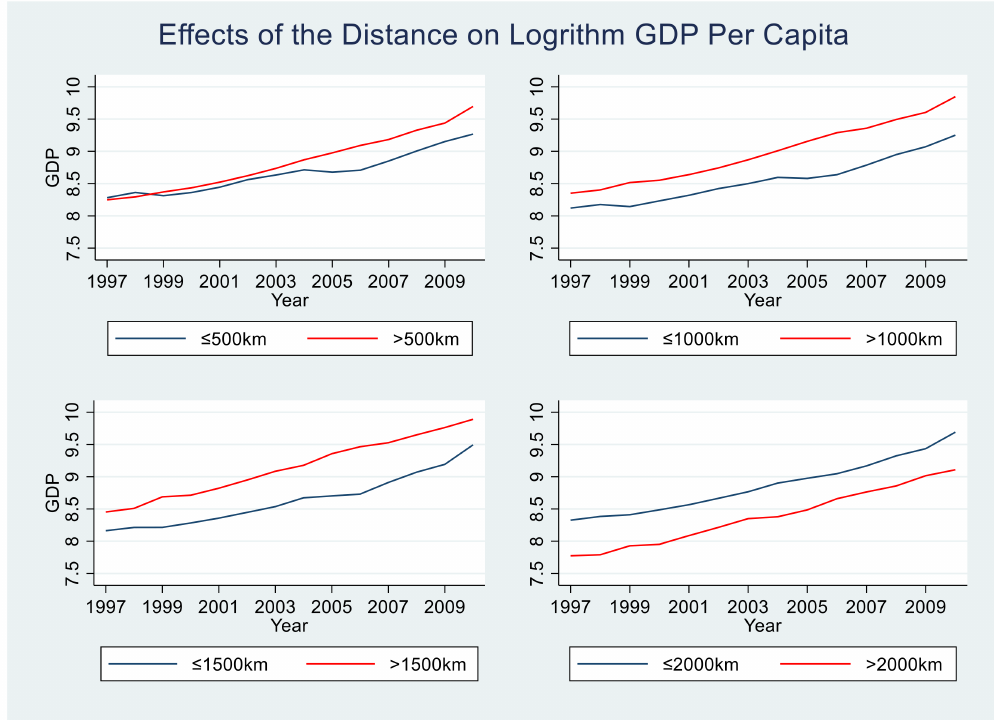
Figure A1. Relationships between distance and